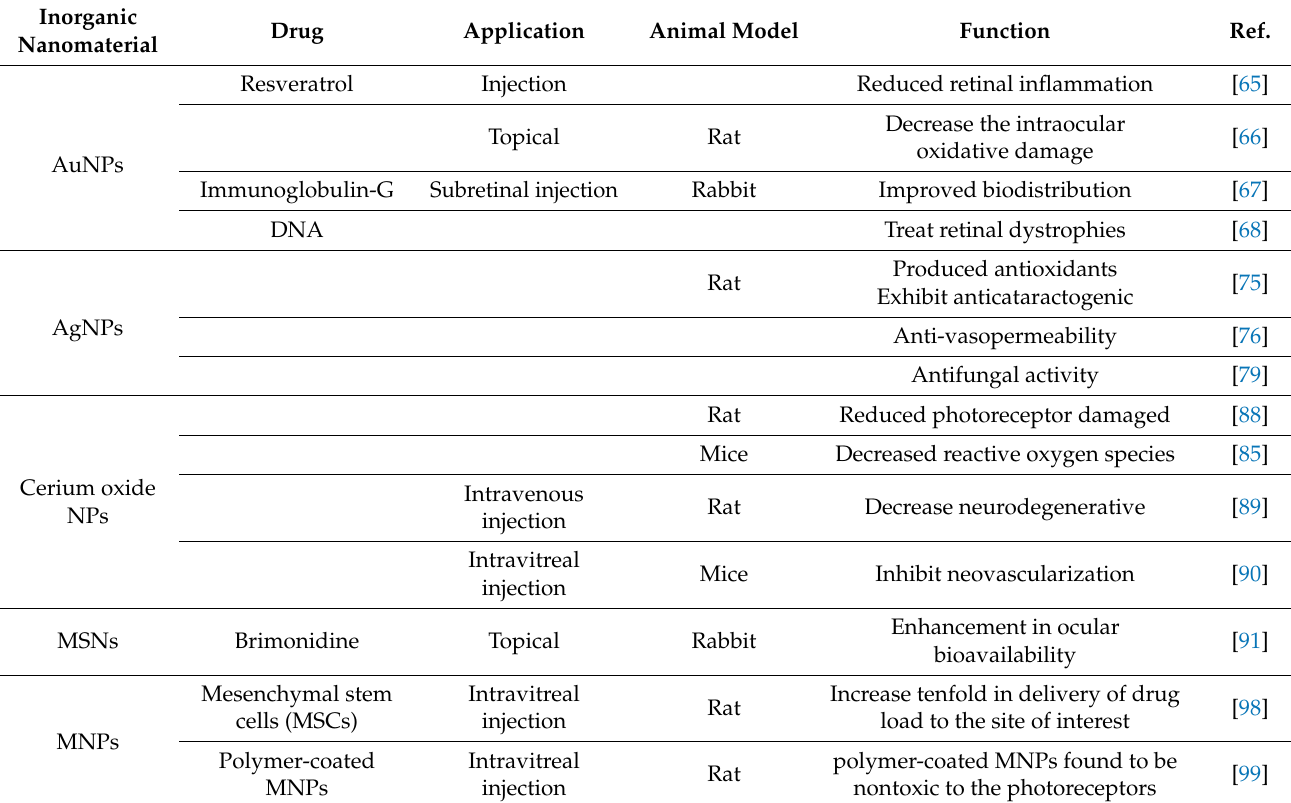
Table 2. Applications of inorganic nanoparticles for drug delivery to ocular